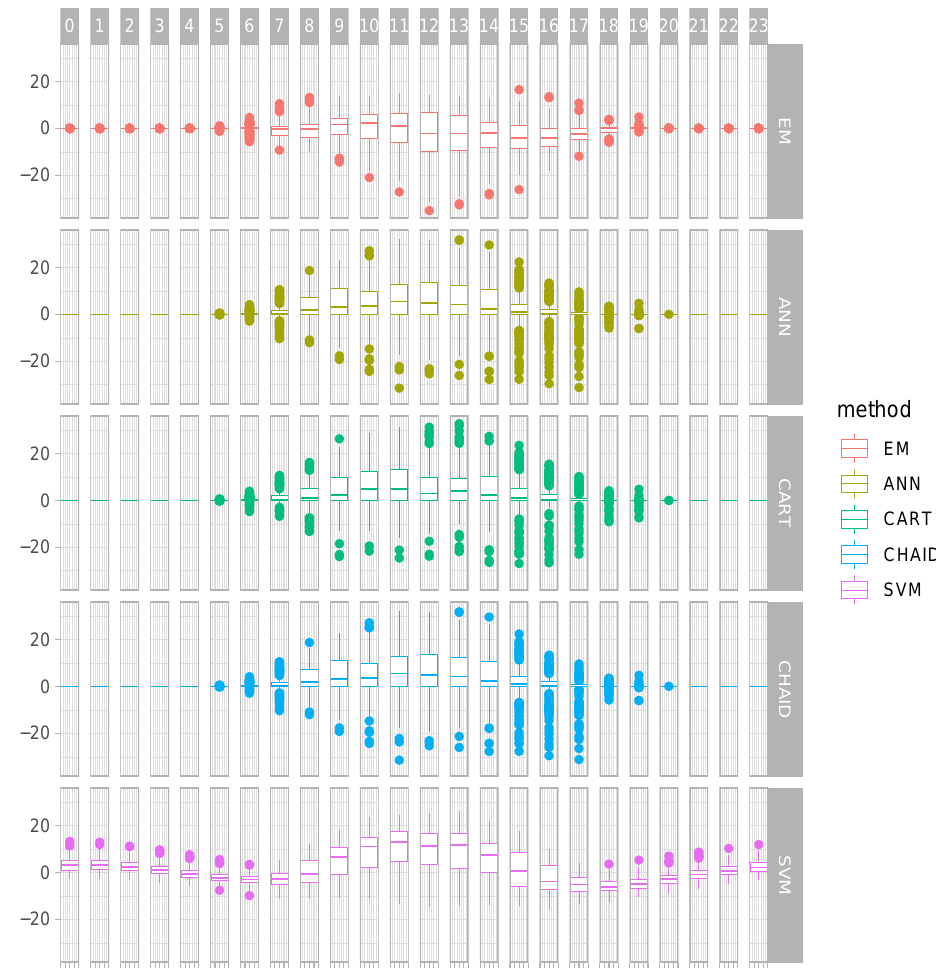
Figure 6. The goodness-of-fit of each model is analyzed by time. Each column represents hours, and each row represents a model. Each figure is a representation of the errors of the relevant method during the relevant